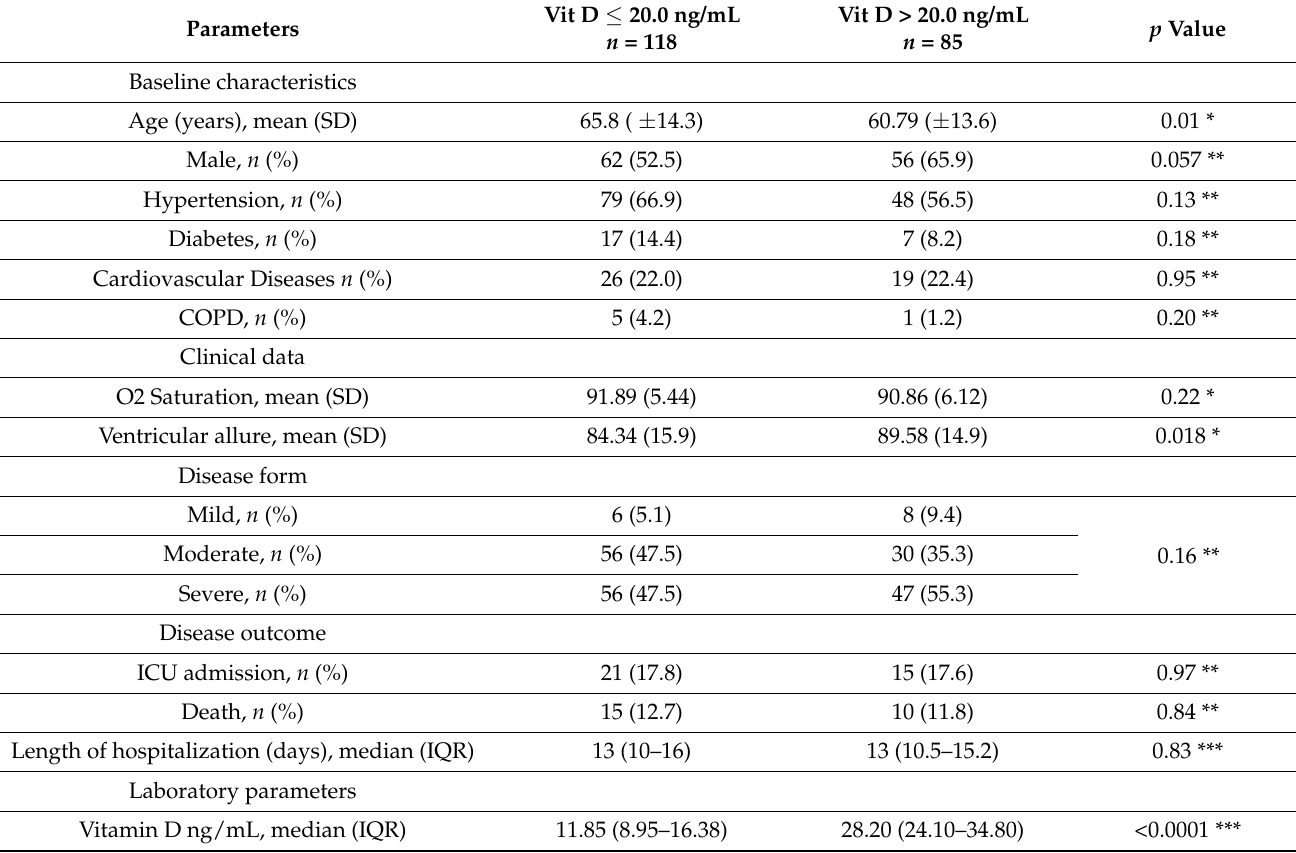
Table 3. The demographic and clinical data after patient dichotomization according to